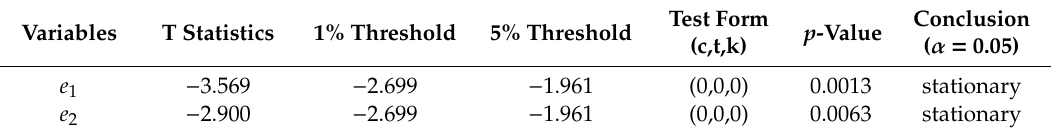
Table 1. ADF unit root test results for regression residual